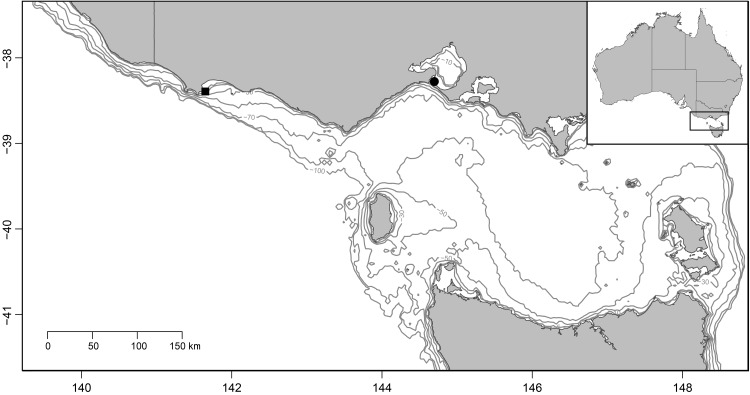
Location of Australasian gannet colonies in the present study, Point Danger (indicated by black square) and Pope’s Eye (indicated by black circle).